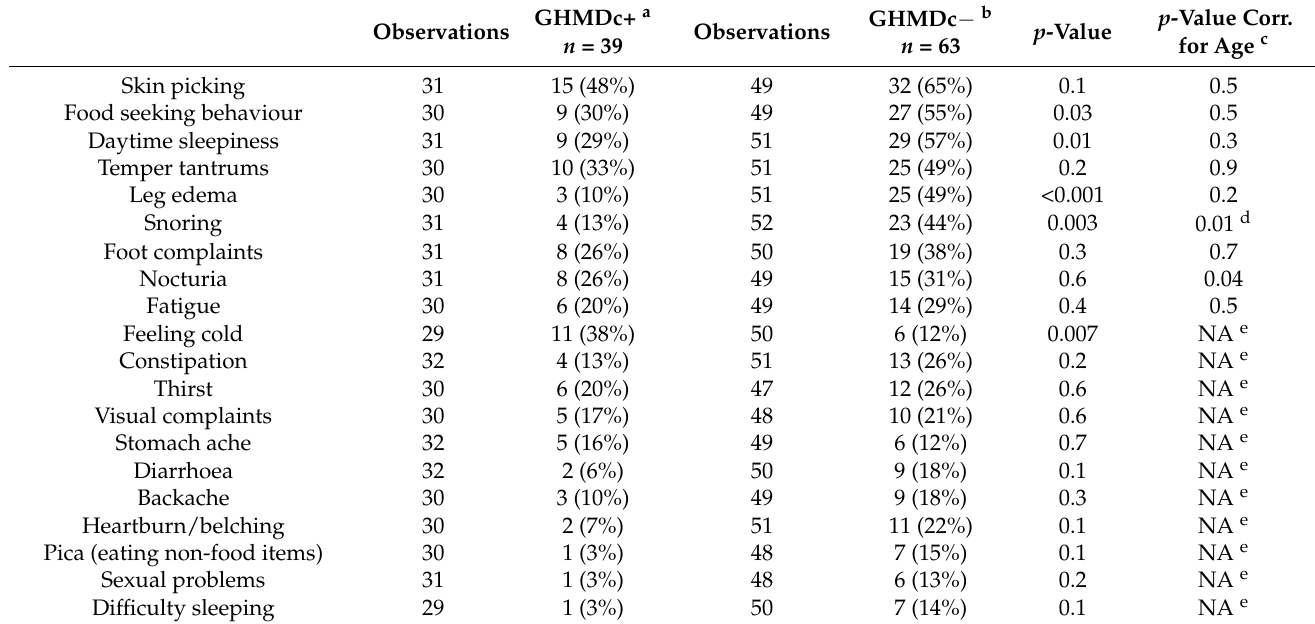
Table 3. Subjective complaints.